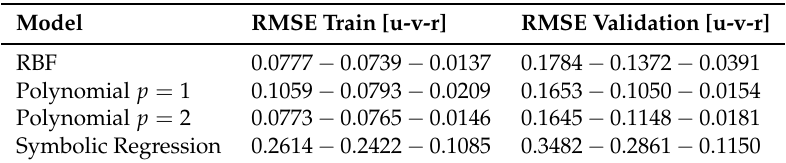
Figure 6. σ -parameter selection for kernel RBF. The units for the RMSE curves in all subplots are m / s for surge speed ( u ) and sway speed ( v ), and rad/s for the yaw rate ( r ). Table 2. Best models for KRR and